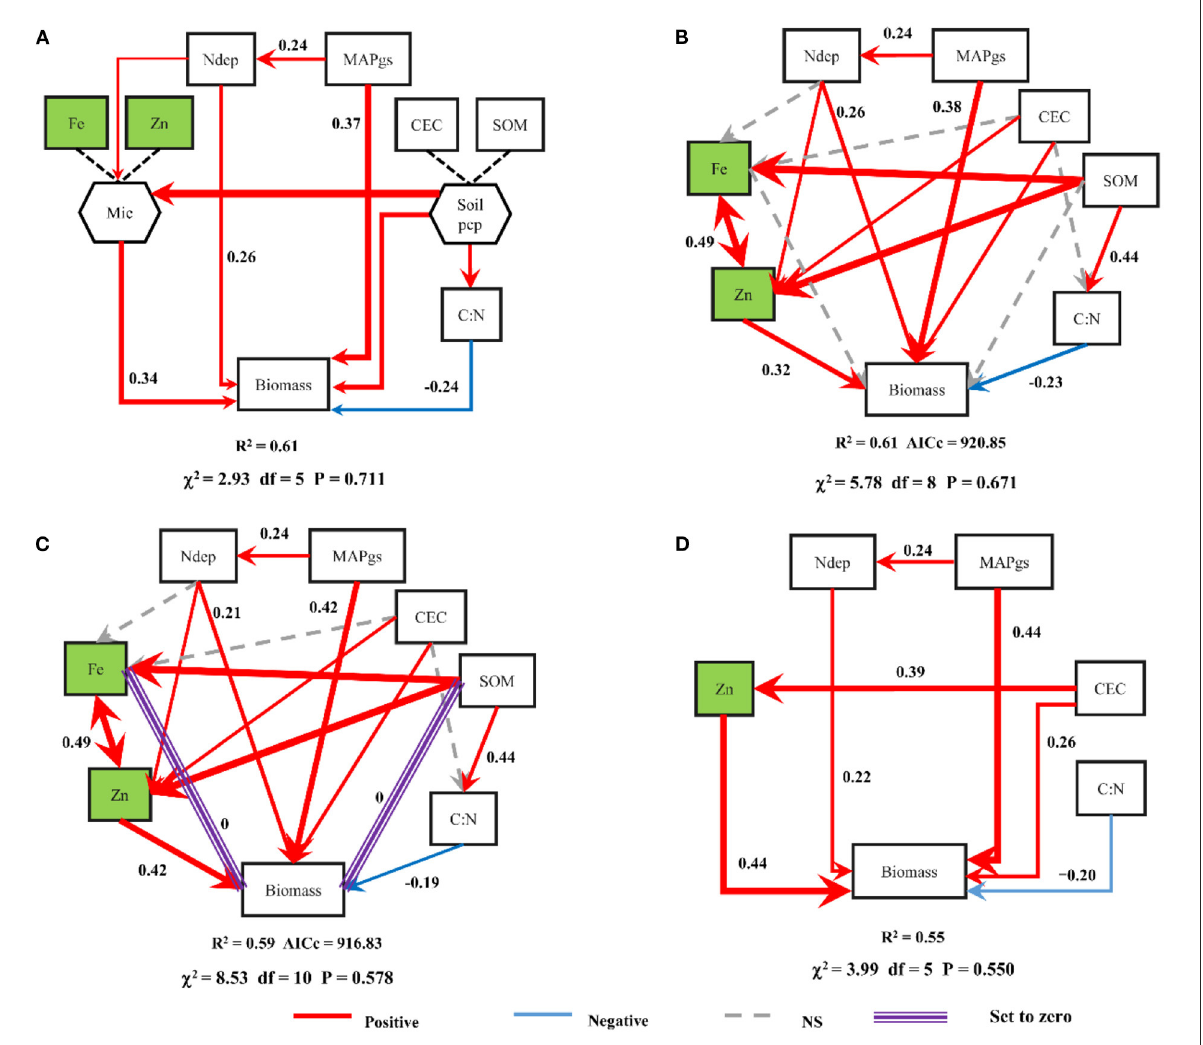
FIGURE1 Comparison of structural equation models (SEMs). Panel (A) , the SEM of Radujkovi´c et al. (2021); Panel (B) , Radujkovi´c’s (2021) SEM without composite variables; Panel (C) shows that the direct effects of both Fe and SOM on Biomass were set to zero. Panel (D) , our best SEM. Numbers along the arrows, and the width of the arrows, indicate standardized path coefficients. MAPgs, mean annual precipitation during the growing season; Ndep, total atmospheric inorganic nitrogen deposition; Fe, extractable iron; Zn, extractable zinc; CEC, cation exchange capacity; SOM, soil organic matter; C:N, carbon-to-nitrogen ratio; Biomass, standing crop (live biomass and recently senescent material) at the peak of the growing